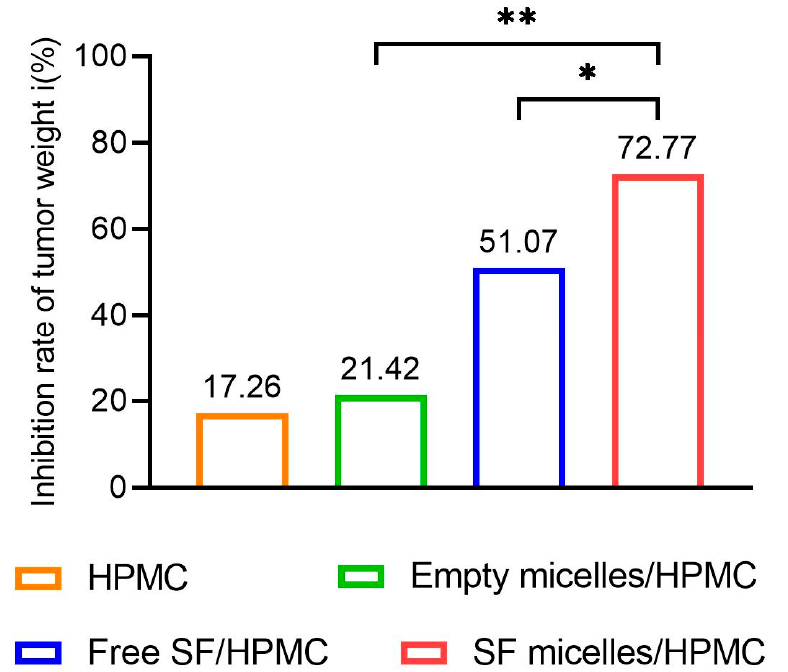
Figure A6. Photographs of orthotopic cervical carcinoma connecting uterus and uterine tubes at the end of treatment.